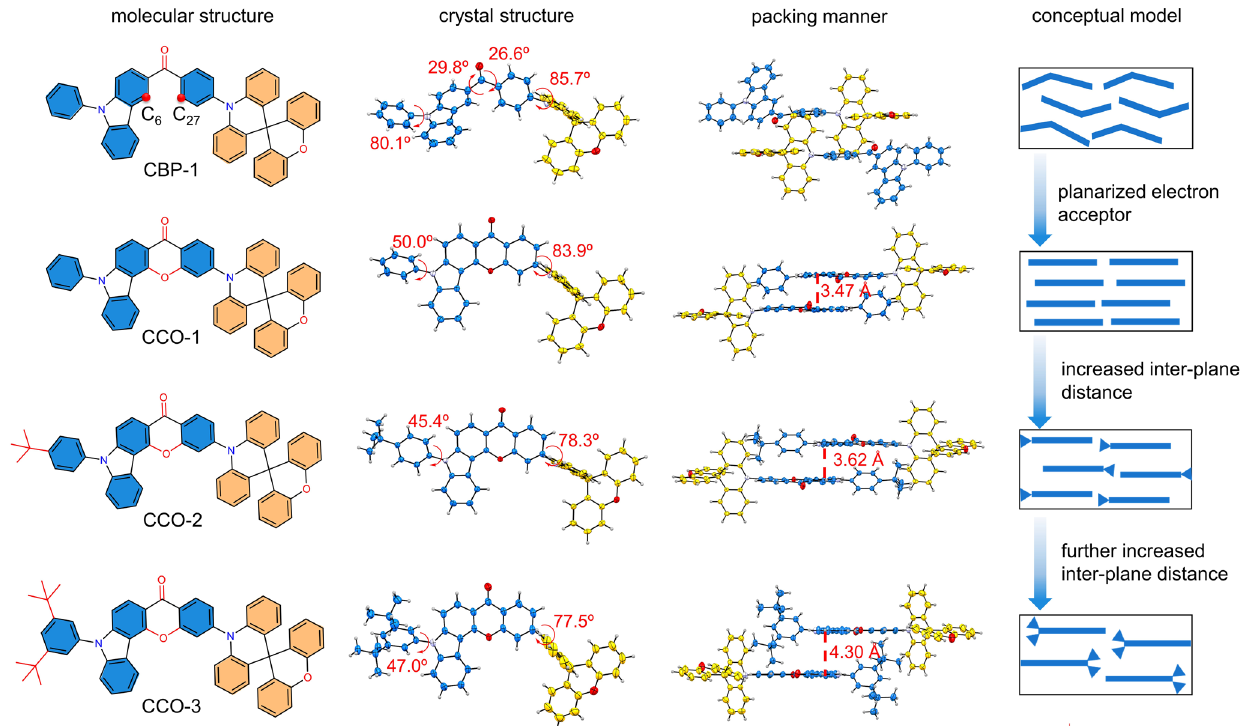
Fig.1|Designstrategyforhigh-ef fi ciencybluedelayed fl uorescencematerials. Molecular structures, crystal structures, packing manners and conceptual models of CBP-1, CCO-1, CCO-2, and CCO-3. The dihedral angles are labeled on the crystal